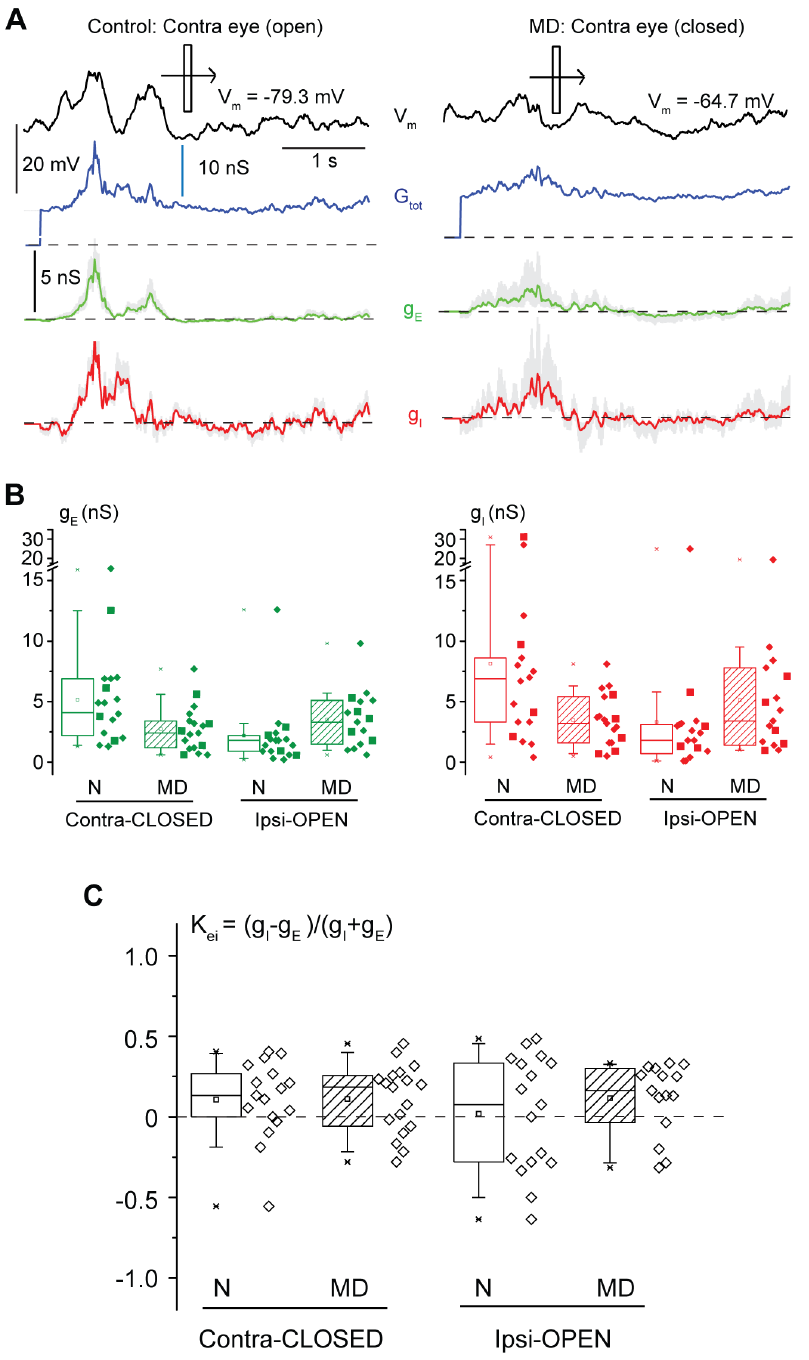
Figure 3. A saturating period of MD reduces both excitatory and inhibitory responses to closed eye stimulation. A . Examples of excitatory (g E , red) and inhibitory (g I , green) responses of 4RSNs (left: normal; right: MD) upon stimulation with optimally oriented light bars. The total membrane conductance (G tot ) is shown in blue and the V m response in absence of current injection is in black (top traces). Dotted lines: 0 nS. Gray shadow: 95% confidence intervals of the g E and g I estimates obtained by bootstrap analysis. B . Amplitudes of the visually-driven g E (green) and g I (red) responses in normal (open boxes) and MD (dashed boxes) rats. MD reduced both excitatory and inhibitory conductances upon contralateral eye (closed in MD rats) stimulation and increased both excitatory and inhibitory conductances upon ipsilateral eye (open in MD rats) stimulation (Mann- Whitney Rank Sum tests, p , 0.05). C . The excitatory-inhibitory balance of visually-driven responses, expressed by the K EI index, was not affected by MD (dashed boxes vs open boxes) for both contralateral and ipsilateral responses (Mann-Whitney Rank Sum tests, p . 0.7).